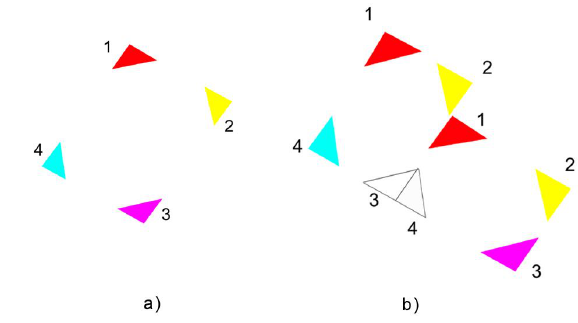
Figure 1: a) corners classification; b) complex structure with a missing point for corners 3 and 4